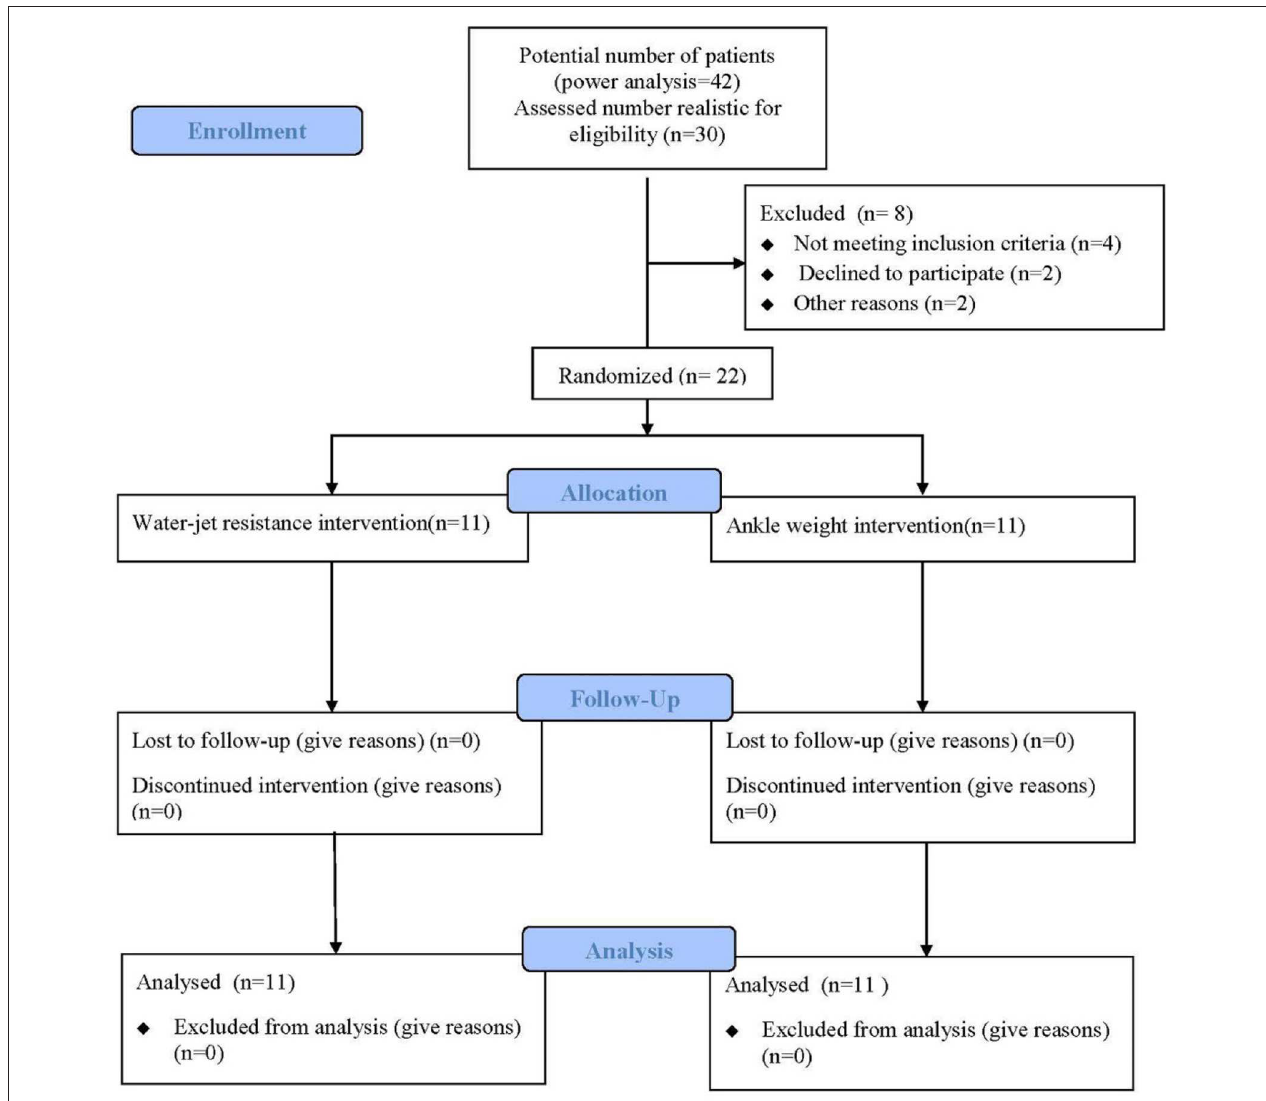
FIGURE 2 | Flow diagram of this study. Twenty-two individuals were enrolled in the study and were randomly assigned to the water-jet group ( n = 11) or the ankle weight group ( n = 11).